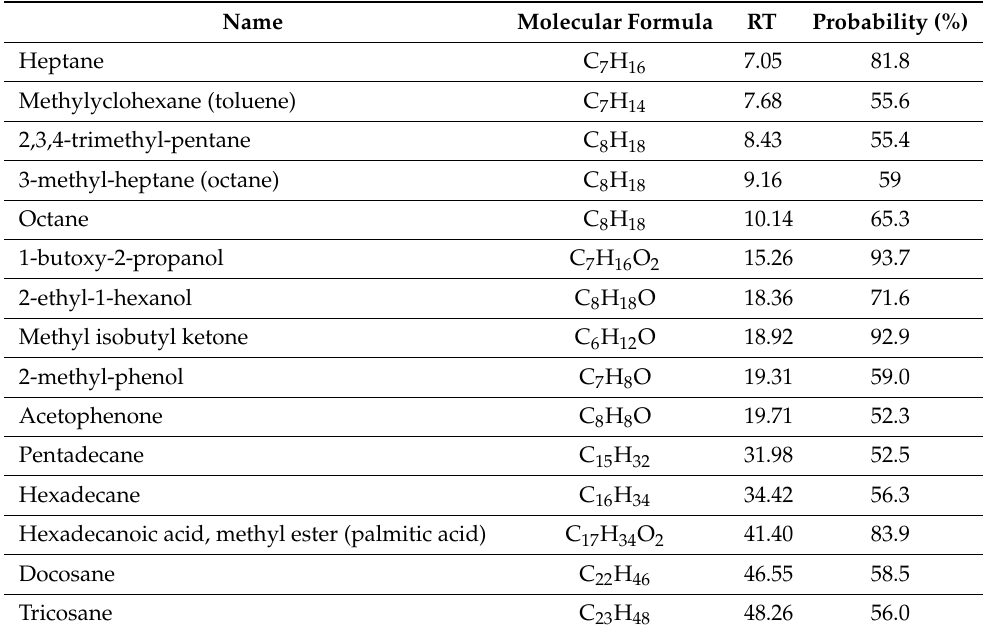
Table 1. Major organic compounds detected in real bilge water (BW) after GC-MS analysis.